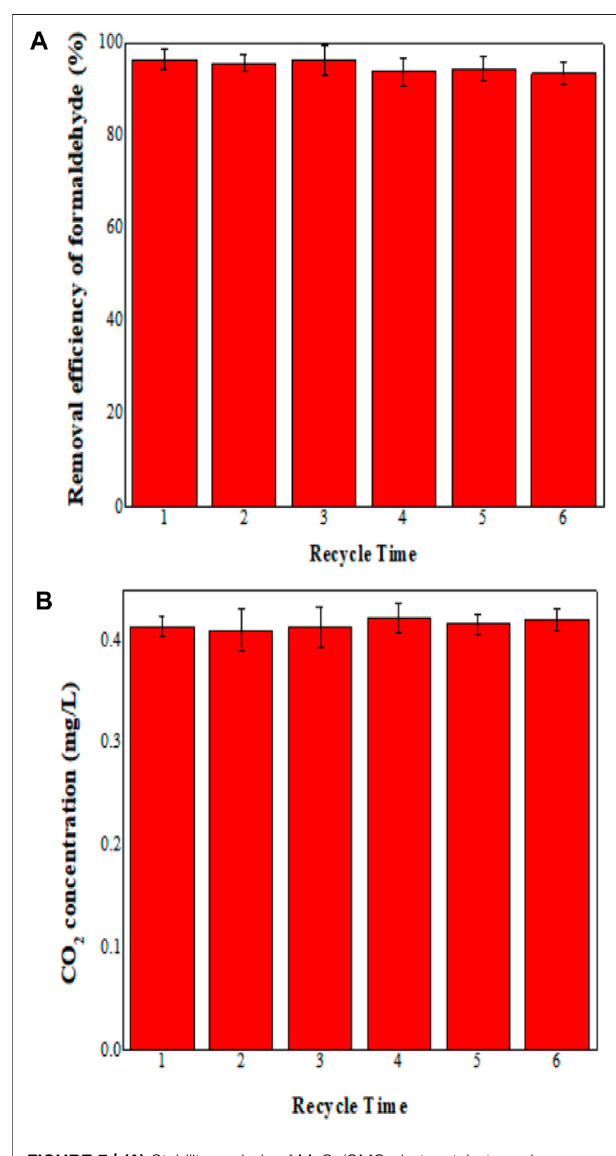
FIGURE 7 | (A) Stability analysis of MoS 2 /OMC photocatalysts under repetitive experiments and (B) CO 2 concentration under repetitive